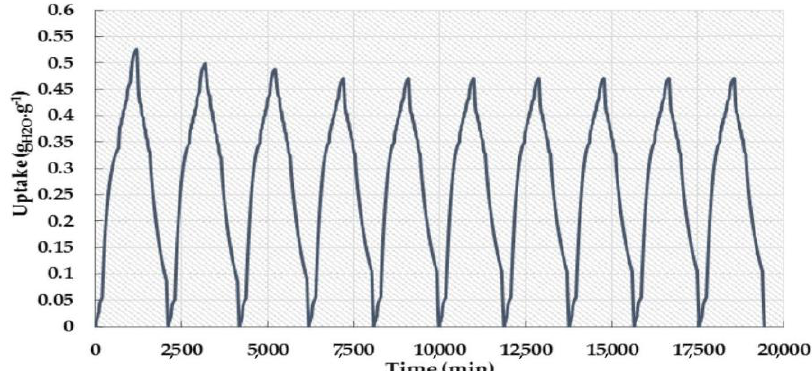
Figure 9. The adsorption/desorption experiments for aluminum fumarate. Reproduced with permission from [72]. Elsevier, 2016.